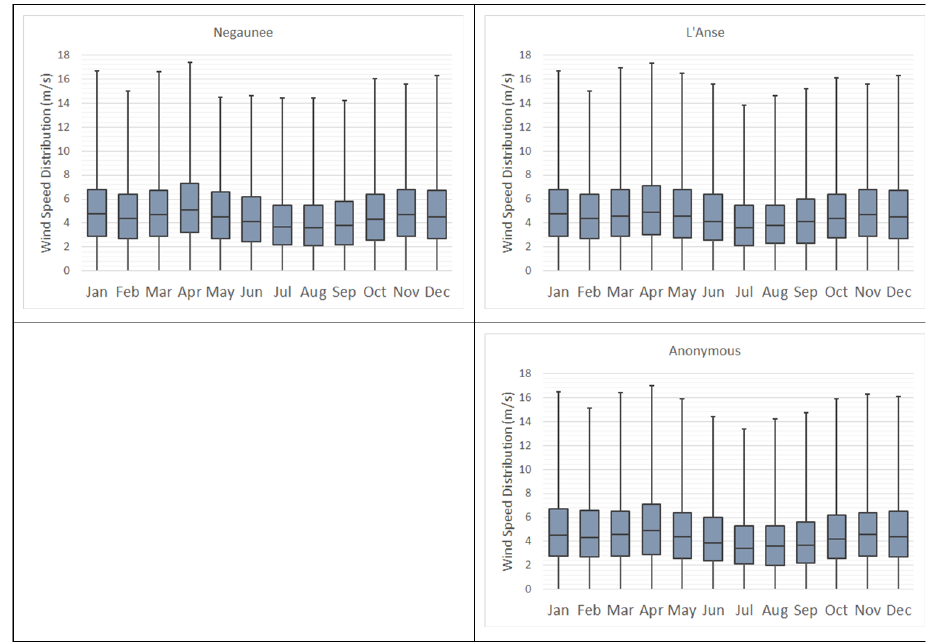
Figure A2. Monthly wind speed distributions for each case